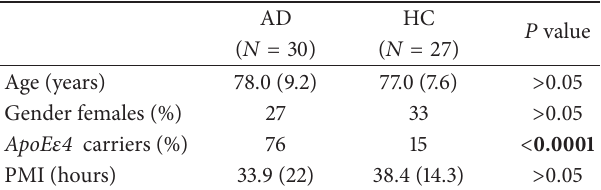
Figure 3: Cu concentration in human erythrocytes. The total Cu content of erythrocytes was determined using ICP-MS. No significant change ( 𝑃 = 0.53 ) in the level of Cu in red blood cells was observed between HC ( 𝑁 = 40 ) (clear boxes) and AD ( 𝑁 = 40 ) (filled boxes). Table 2: Post-mortem subject demography.